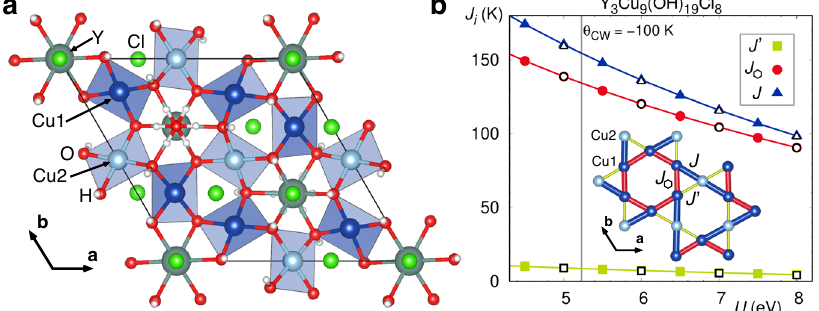
Fig. 6 Structure and exchange couplings of Y 3 Cu 9 (OH) 19 Cl 8 . a Crystal structure of Y-kapellasite 26 (space group 148, R 3 ) with DFT relaxed hydrogen positions. b Exchange couplings of Y 3 Cu 9 (OH) 19 Cl 8 as a function of interaction strength U , determined by energy mapping using GGA + U at J H = 1 eV . Solid symbols: P 1 cell, 7 couplings extracted. Empty symbols: shows the nearest-neighbor exchange paths of the perfect kagome lattice which differentiate into J ⬡ , J , and J 0 in